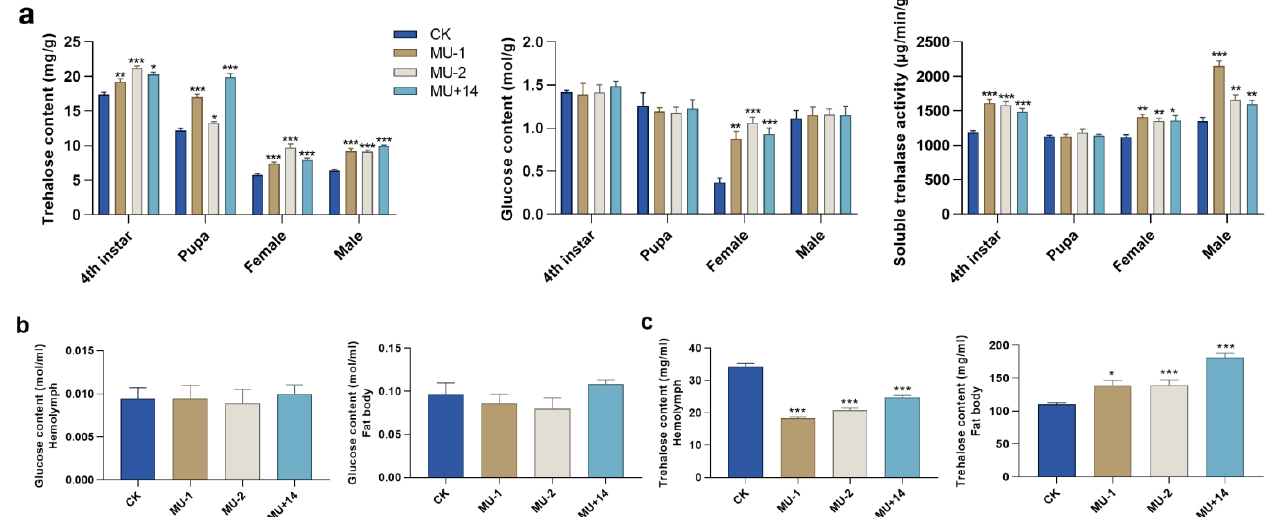
Figure 6. Effects of PxTret1-like knockout on trehalose content, glucose content and trehalase activity. ( a ) Trehalose content, glucose content and trehalase activity in 4th-instar, pupae, female adults and male adults of Plutella xylostella ; ( b ) trehalose content in hemolymph and fat body; ( c ) glucose content in hemolymph and fat body. Independent-samples T-test was used. Error bars represent standard error of the mean. Independent-samples T-test was used. * indicates p < 0.05; ** indicates p < 0.01; *** indicates p < 0.001.